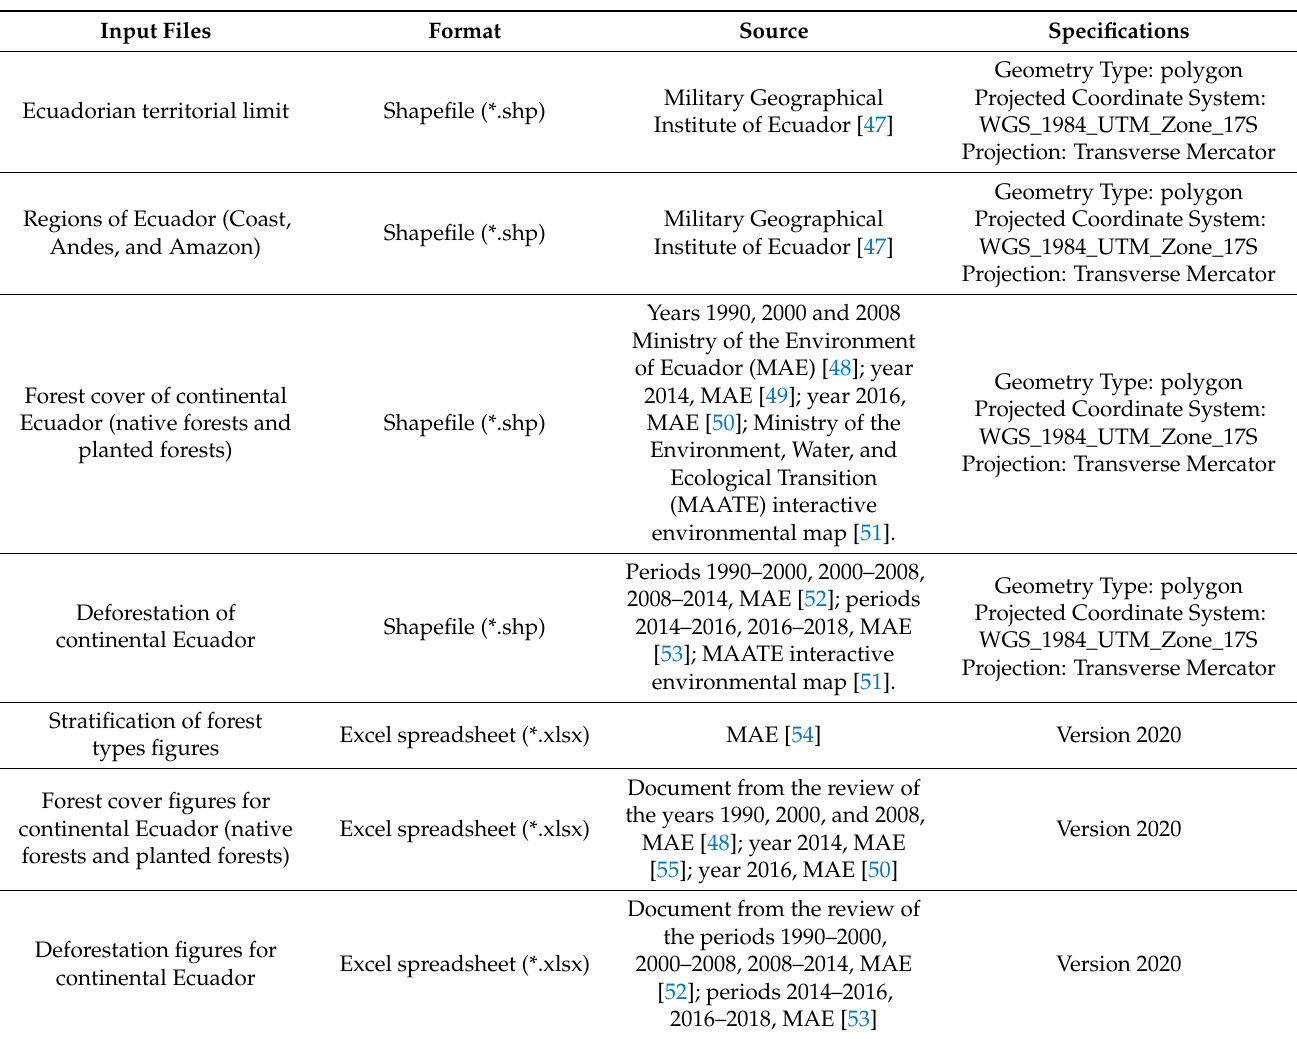
Table 1. Input files used for the elaboration of the forest cover map of